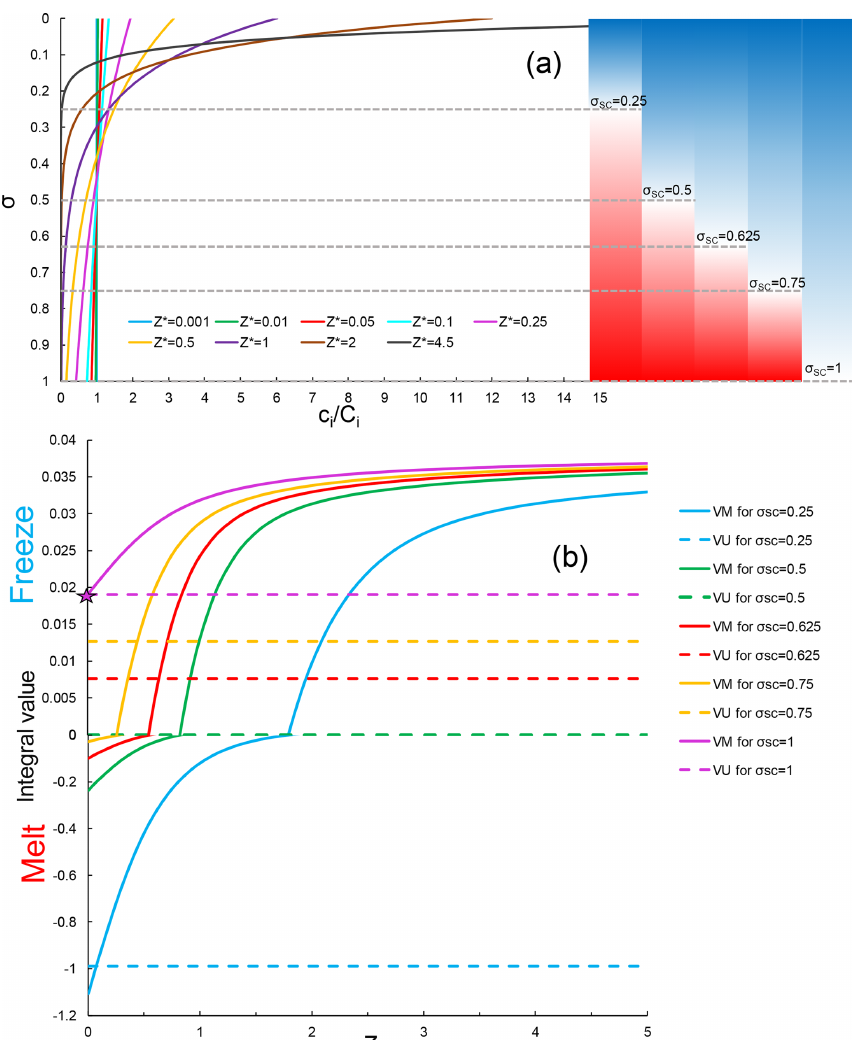
Figure 2. (a) Exponential profiles of equilibrium frazil concentration for selected values of Z ∗ . Coloured bars at the right and horizontal dashed lines indicate the distributions of supercooling (blue, T SC > 0 ) and overheating (red, T SC < 0 ) for the values of σ SC used in panel (b) . (b) Dependence of integral value of I gr on Z ∗ for suspended frazil-ice freezing ( I gr > 0 ) and melting ( I gr < 0 ) under the supercooling conditions shown in panel (a) . The star denotes the particular conditions under which the integral values of I gr calculated using VU and VM formulations are equal. Note that different y -axis scales are used for freezing and